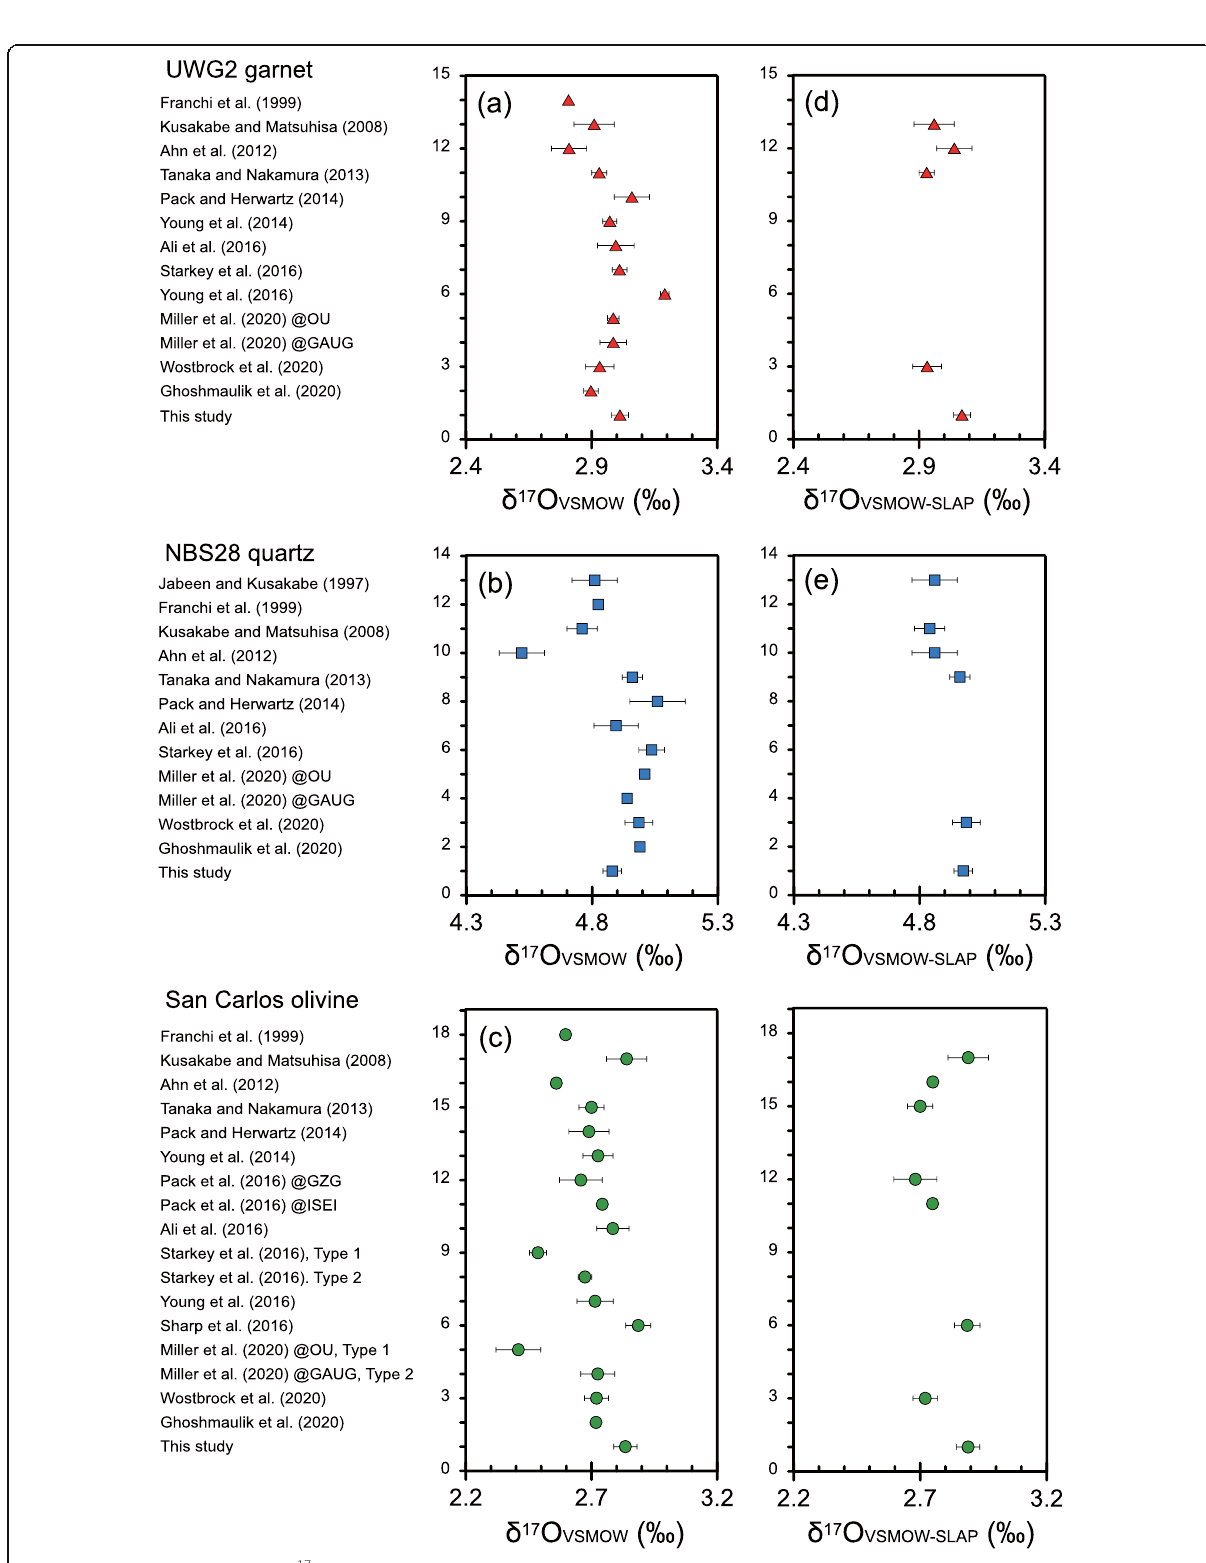
Fig. 4 Comparison of published δ 17 O values relative to VSMOW ( a – c ) and VSMOW-SLAP ( e – f ) for international silicate